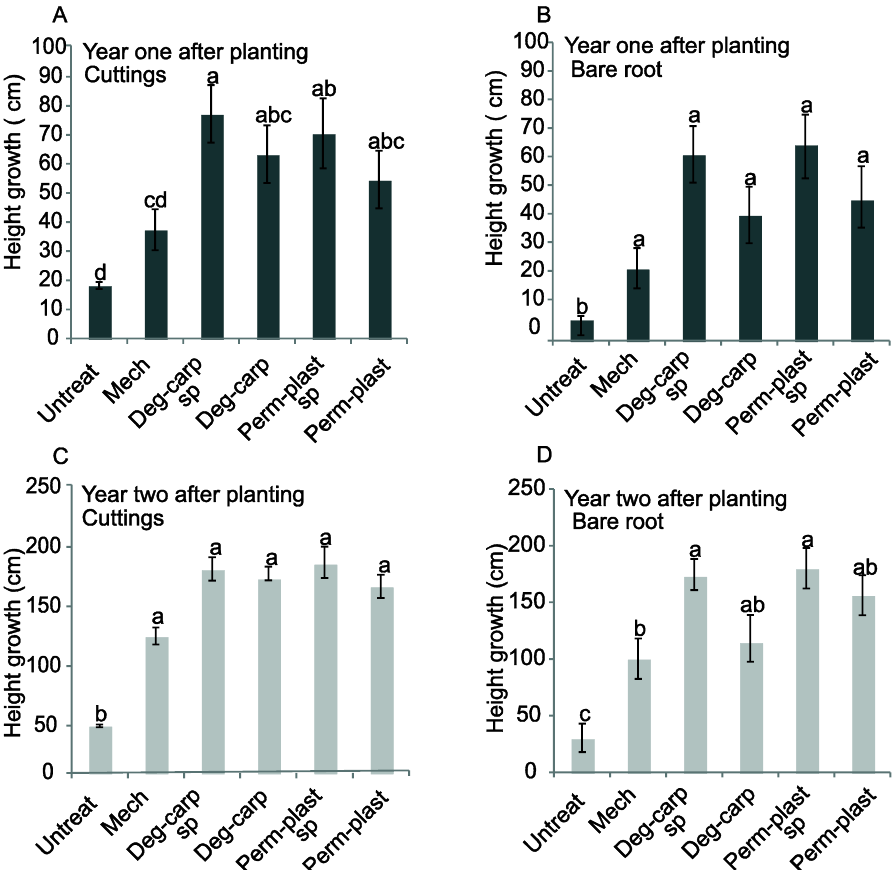
Figure 1. Height growth the first and second years after planting. Height growth of seedlings from un-rooted cuttings ( A and C ) and rooted plants ( B and D ), one year ( A and B ) and two years ( B and D ) after planting under each of the treatments: control (Untreat), mechanical vegetation control (Mech), mulching without soil preparation using degradable carpet (Deg-carp) or permanent polypropylene plastic (Perm-plast), and with soil preparation (Perm-plast sp and Deg-carp sp). Values with the same letter are not significantly different at the p = 0.05 level: means ( n = 3), error bars indicate standard